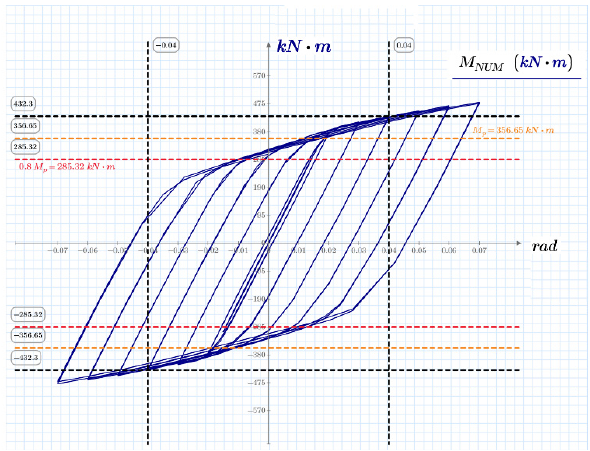
Figure 8. Hysteretic curve (moment–angle).